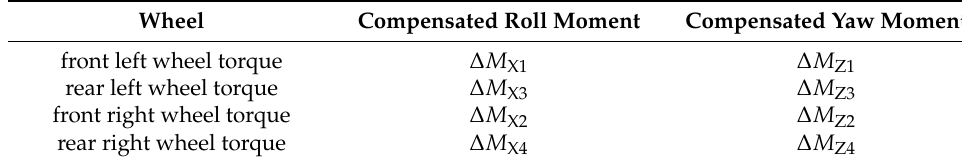
Table 2. Compensating roll and yaw moment for 4